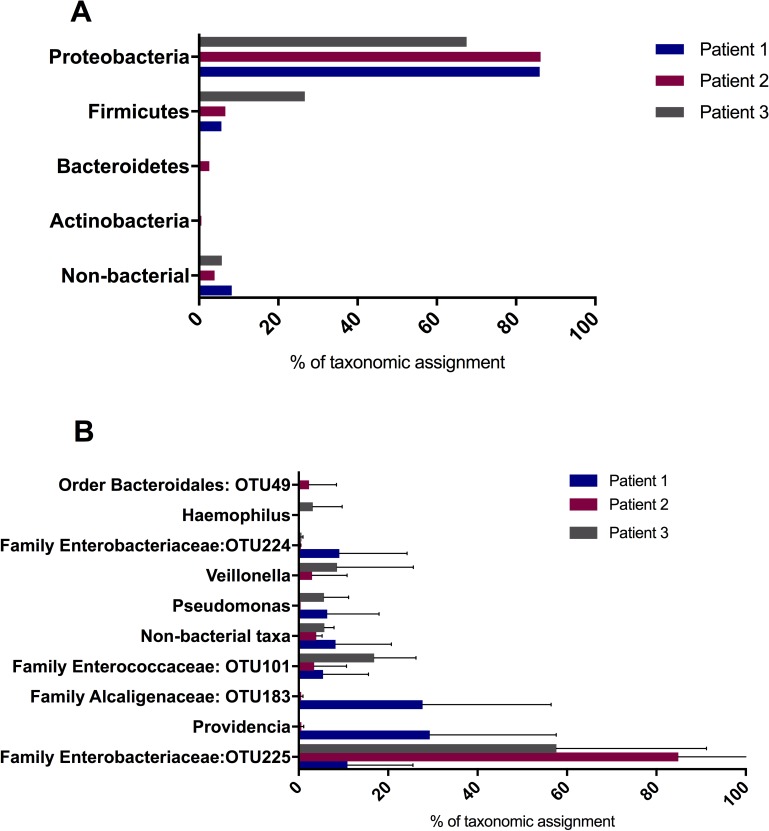
Taxonomic distribution of microorganisms in catheterized patients.(A) Phyla as a percentage of taxonomic assignment in urinary catheter microbiota of the three patients across probiotic treatment and post-treatment time points based on meta-community sequence analysis. (B) Genera as a percentage of taxonomic assignment for the three patients across probiotic treatment and post-treatment time points based on meta-community sequence analysis. Only genera with an average representation of 1% or greater are shown. Error bars show standard deviations. OTUs that were not resolved at the genus level are referred to by their lowest identified phylogenetic classification and OTU number. Only phyla with a representation of at least 1% in a single individual’s catheter microbiome are shown.